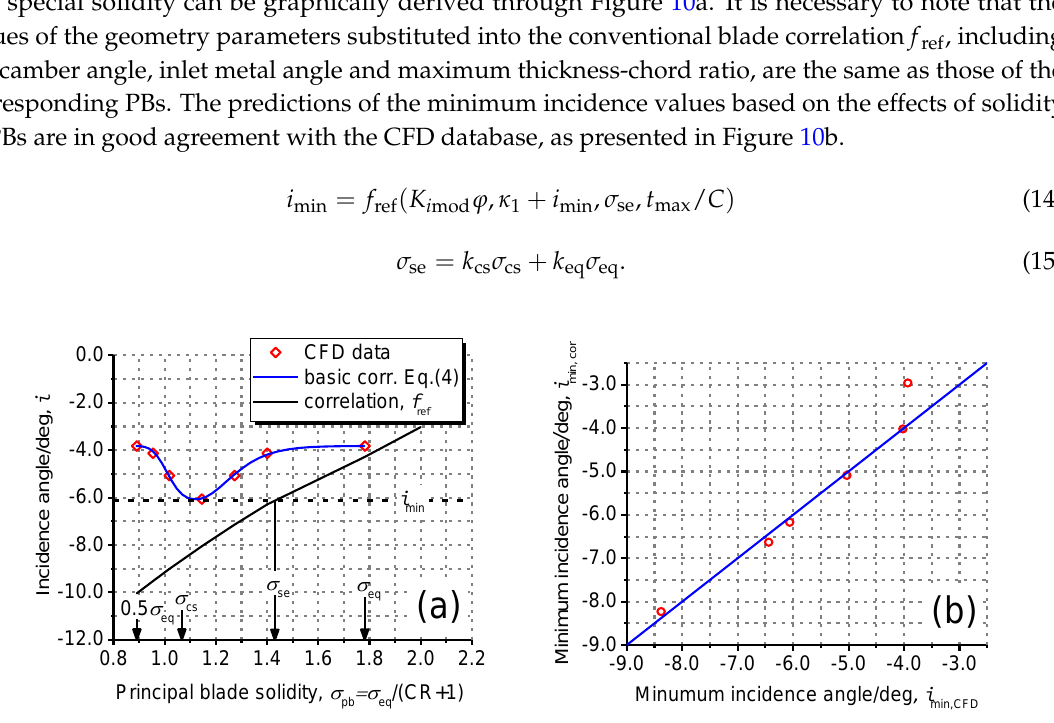
Figure 10. ( a ) Re-illustration of Figure 8a with solidity of PBs and ( b ) comparison between model predicted i min,cor and CFD calculated i min,CFD .